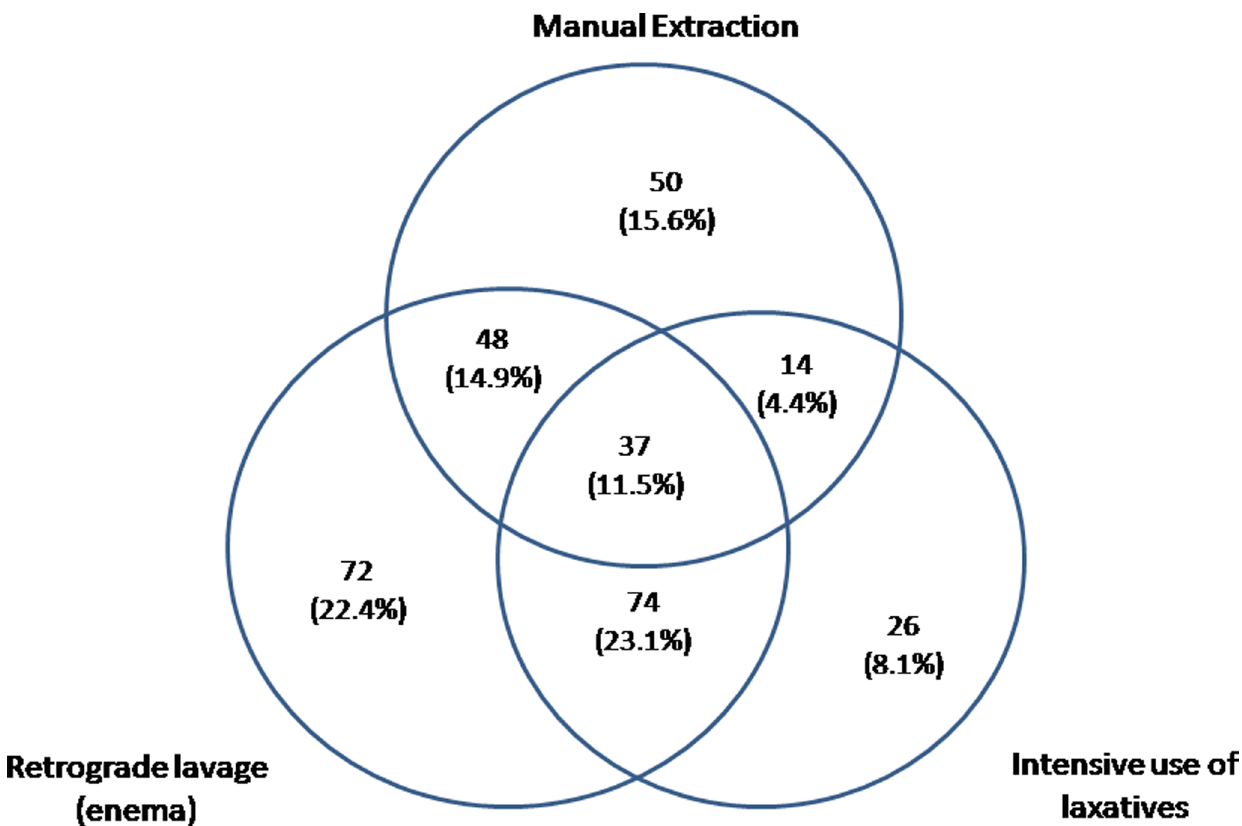
Figure 2. Methods used to solve fecal impaction in the population studied.